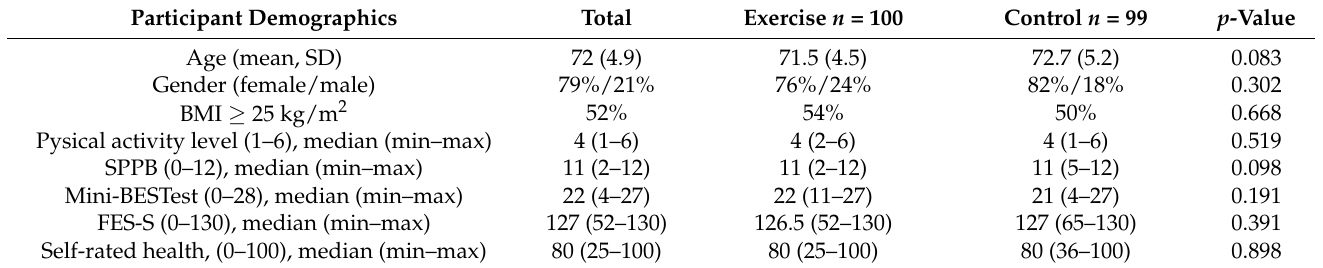
Table 1. Baseline